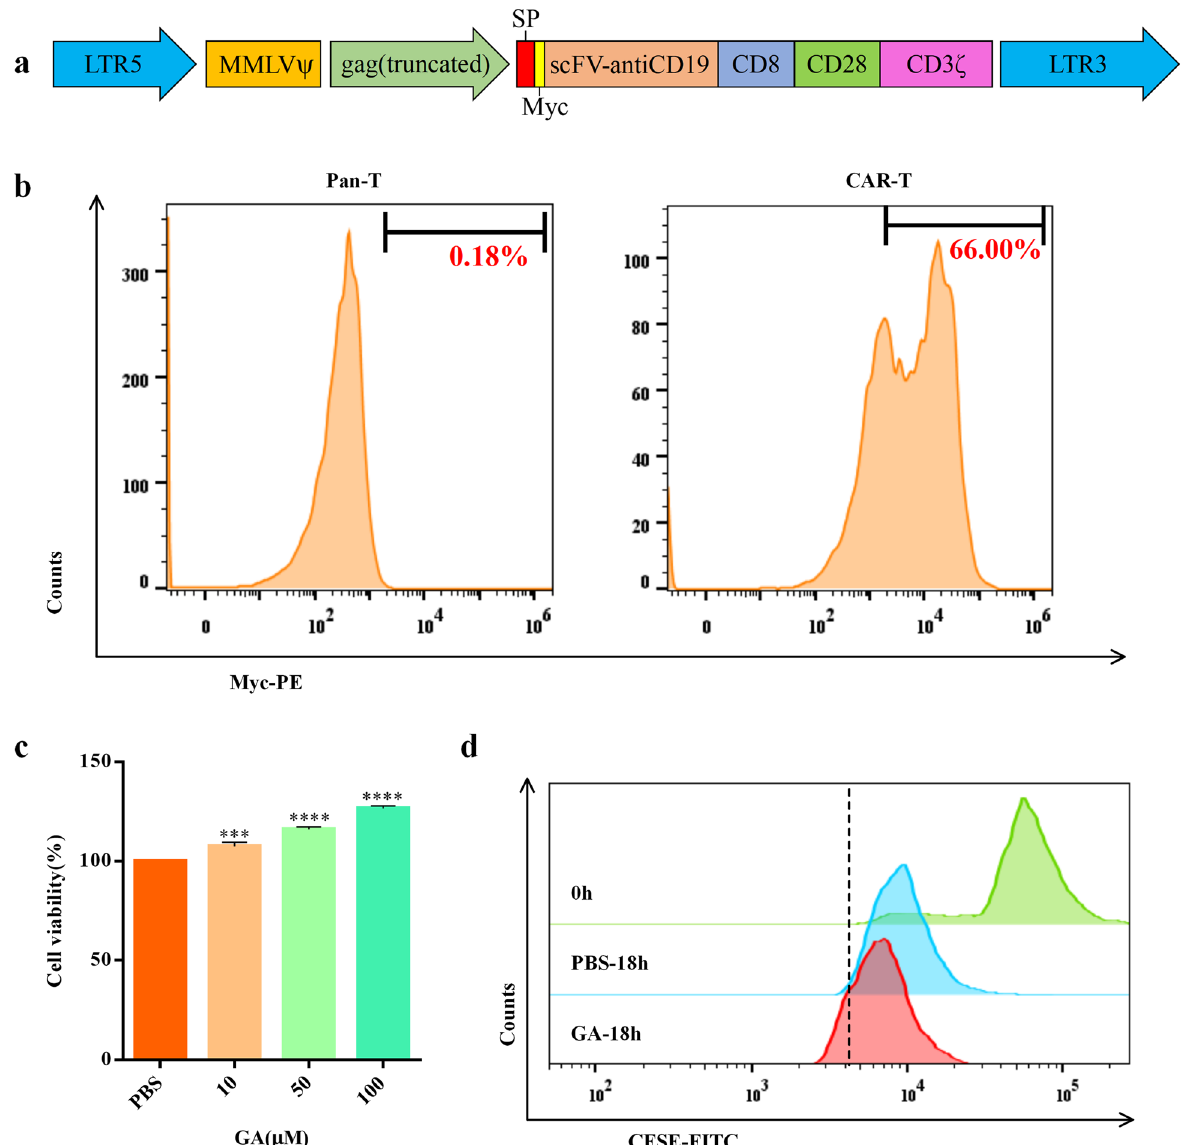
Fig. 1 GA improved the cell viability and proliferation of anti-CD19 CAR-T cells in vitro . a The construction of anti-CD19 CAR. b The transduction efficiency of CD19 CAR in primary T cells. c The cell viability of anti-CD19 CAR-T cells determined by PrestoBlue ™ assay. Values were expressed as the means S.D.. * P < 0.05; ** P < 0.005; **** P < 0.0001 ( n 6). d The proliferation of anti-CD19 CAR-T cells determined by CFSE assay (GA: 100 μM). PBS, ± = phosphate buffered saline; FITC, fluorescein